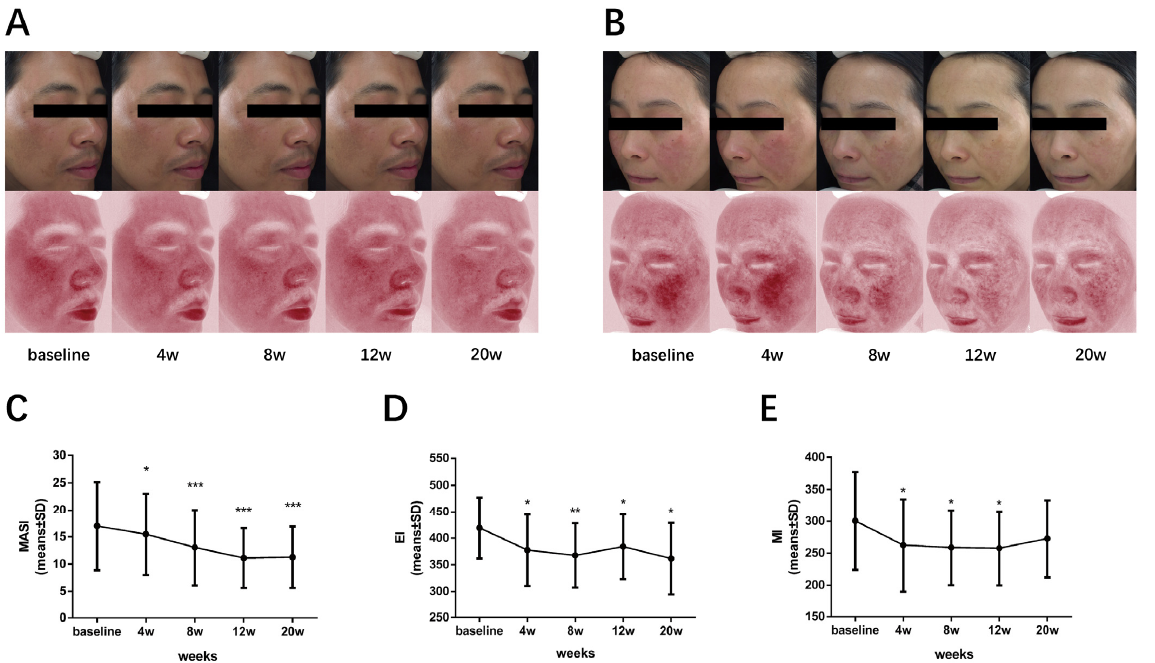
Figure 6. Improvement of hyperpigmentation and erythema in melasma patients after 590 nm LED light therapy. ( A , B ) Representative photographs (upper panel) and VISIA images (lower panel) of two melasma patients, showing significant improvement of hyperpigmentation and erythema after phototherapy. The change in mean MASI score ( C ), EI ( D ) and MI ( E ) of all patients enrolled during the course, shown as means ± SD. n = 10. *, p < 0.05; **, p < 0.01; ***, p < 0.001. MASI, melasma area severity index; EI, erythema index; MI, melanin index.